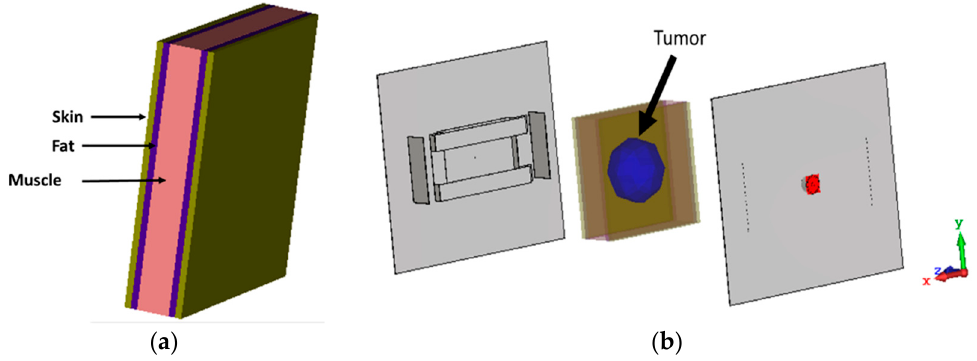
Figure 9. ( a ) Human tissue phantom; ( b ) simulation setup for microwave imaging.